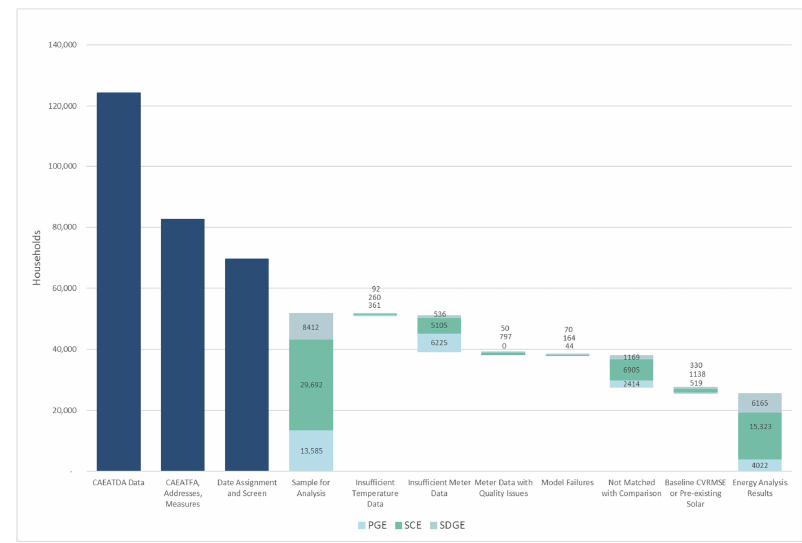
Figure A1. Electric sample attrition.